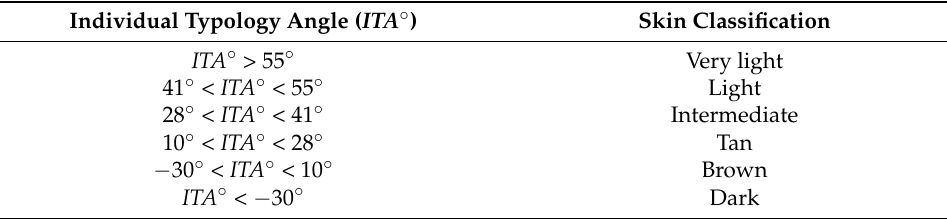
Table 1. Fitzpatrick skin-type classification results